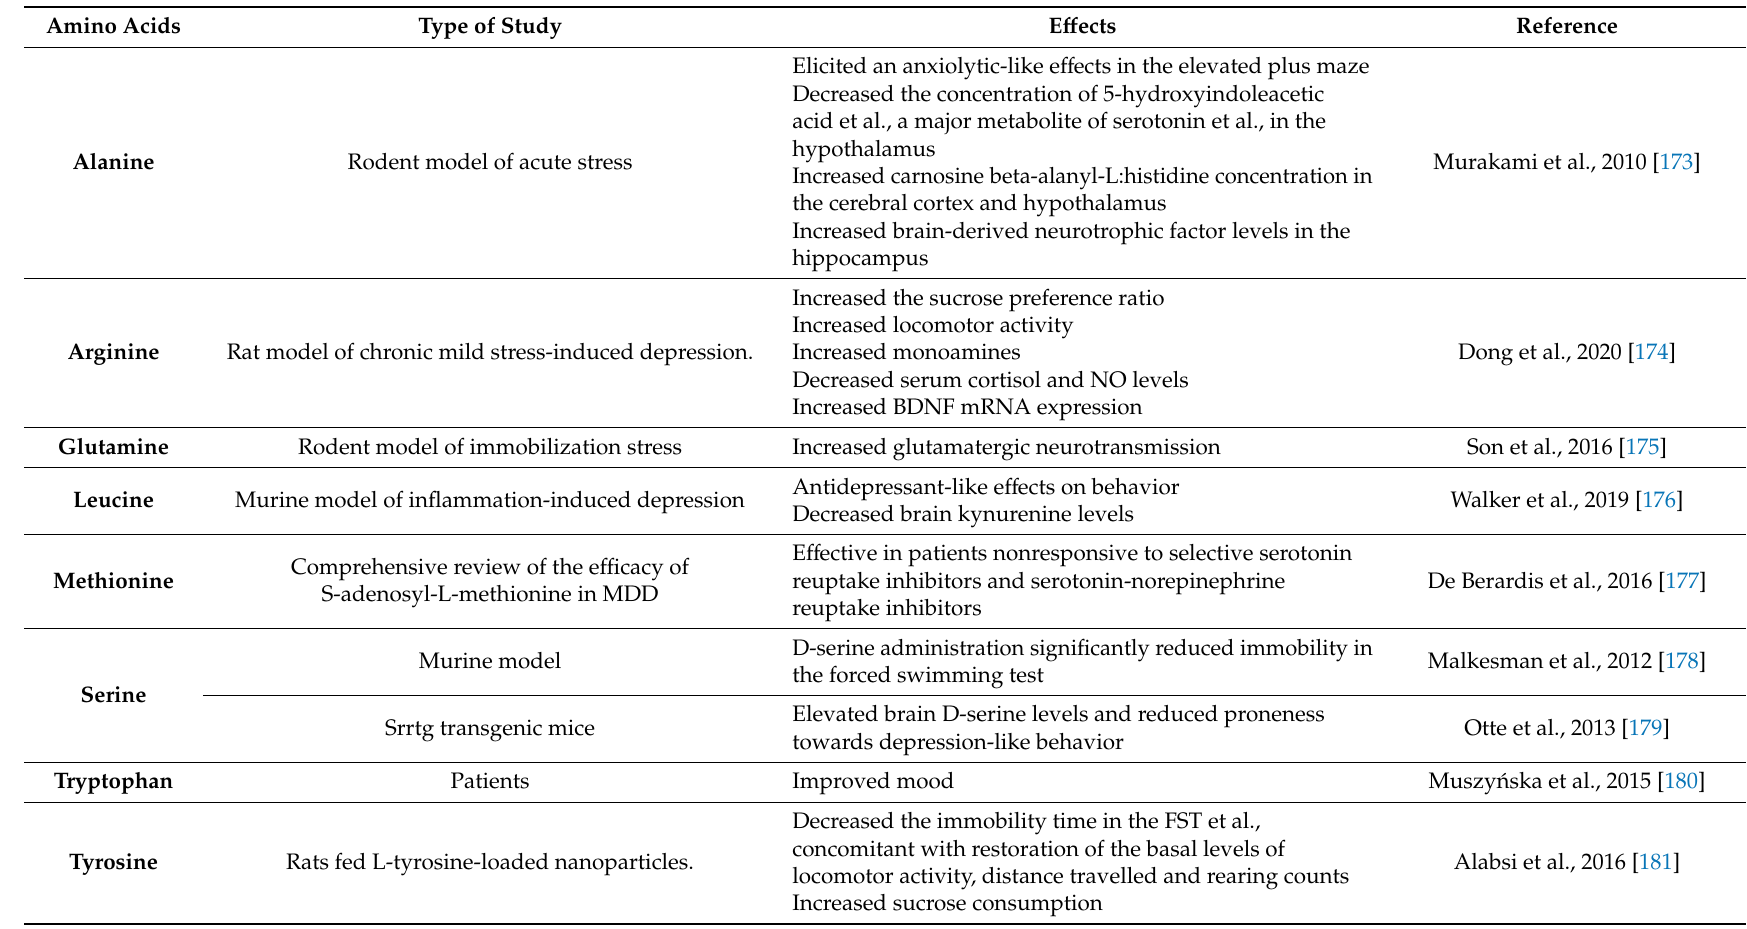
Table 4. Antidepressant and anxiolytic e ff ects of AAs in preclinical and clinical